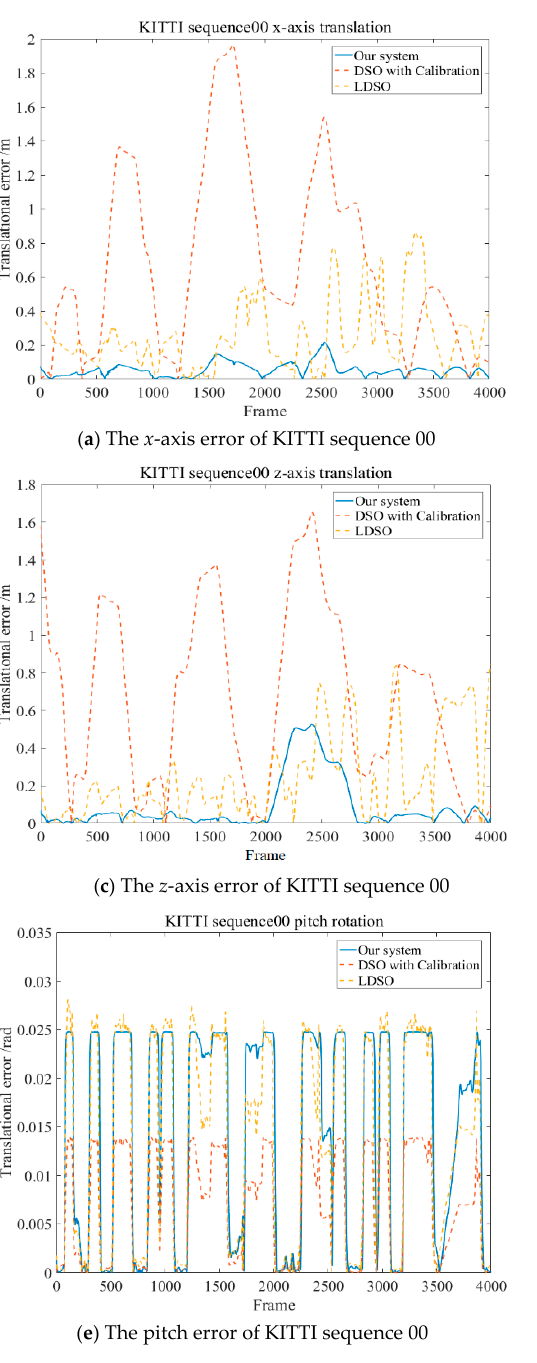
Figure 13. The residuals of the 6-DoF on KITTI sequence 00 including the translations and Euler angle of rotations. The residuals of subfigure ( b ) were obviously larger in the both proposed system and LDSO because of the introduction of loop closure detection. However, the error tendencies on x -axis and z -axis were primarily lower than LDSO and the enhanced DSO [14]. In general, the translation error and rotational error of the proposed system were stably maintained as reasonable values along all frames of KITTI sequence 00.